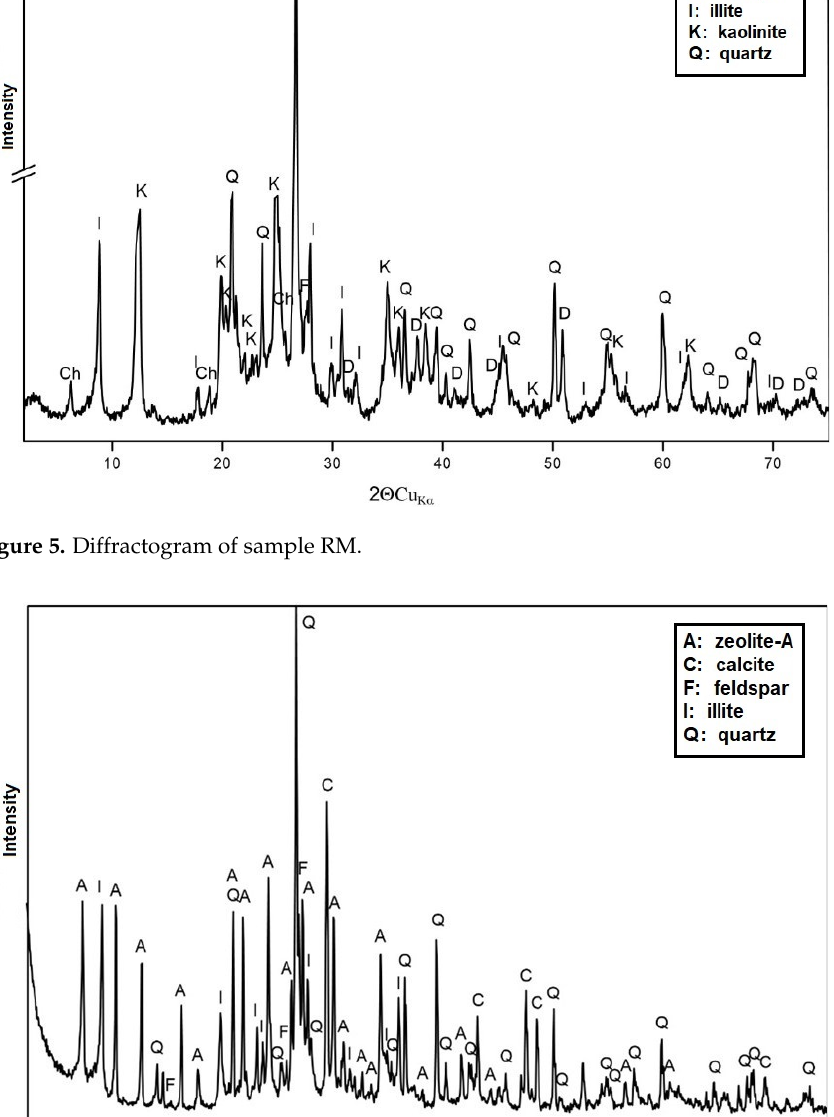
Figure 6. Diffractogram of sample AS.